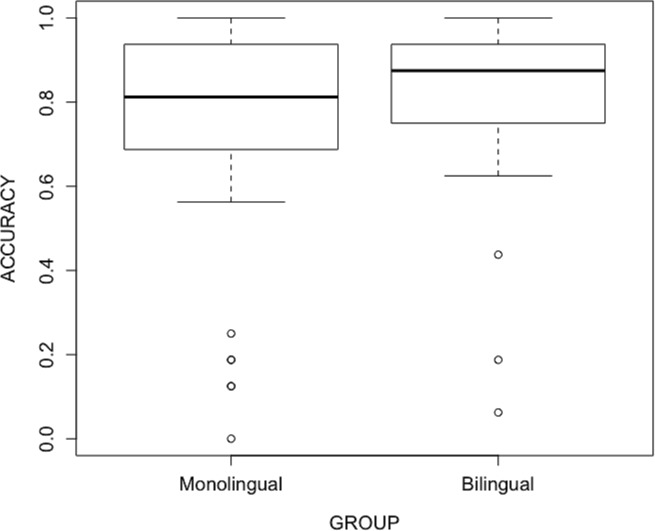
Accuracy score means per participant on target trials, across the bilingualism factor.